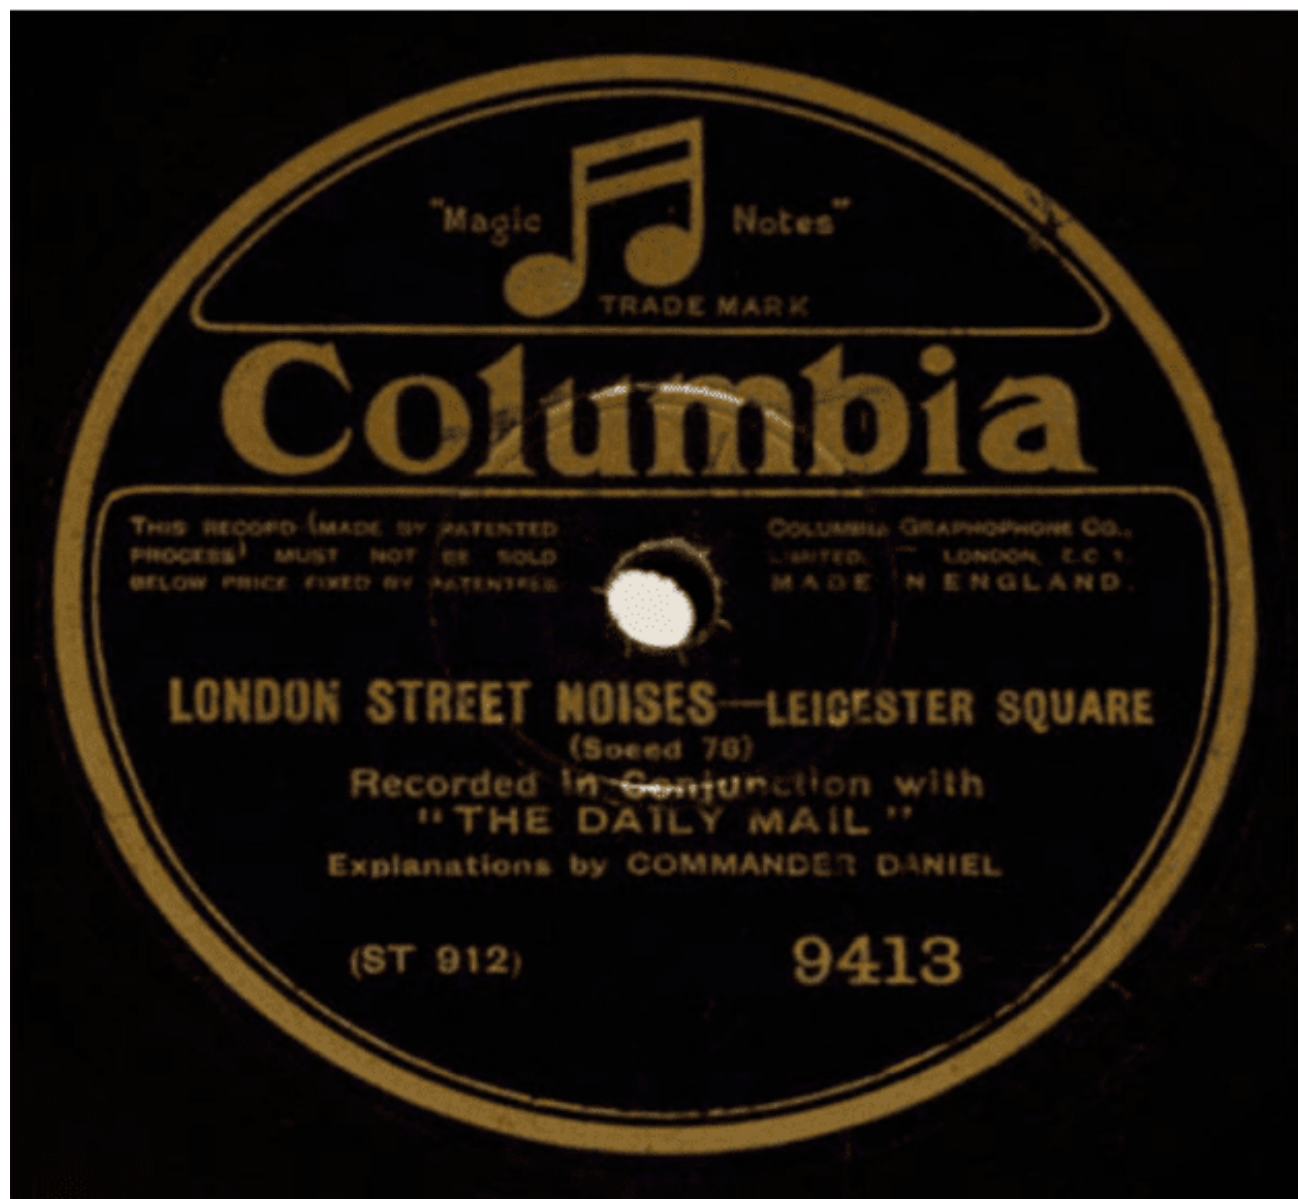
Figure 1. Published Columbia Records London Street Noises (LSN) disc label. Commander Daniel was somewhat of a hero for the Daly Mail readership of the day. The LSN recordings quickly follows his departure from the Royal Navy, due to his in-